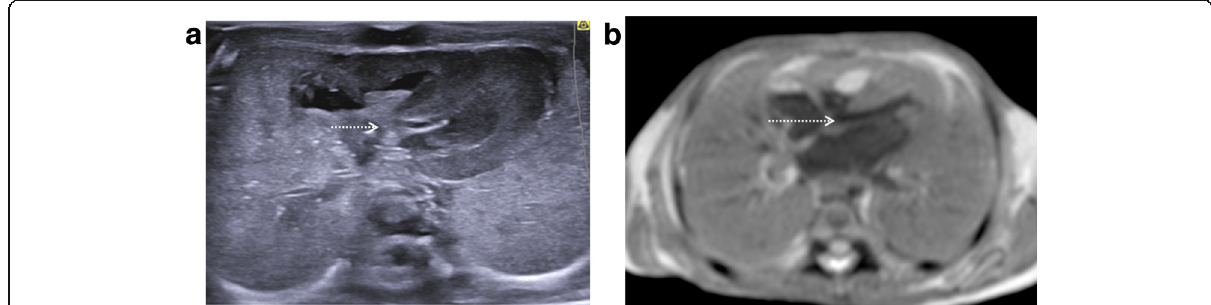
Fig. 11 Paired transverse images of the four cardiac chambers in a foetus at 19 weeks gestation, obtained 6 days after termination of pregnancy. Post-mortem ultrasound image ( a ) and T2-weighted MRI at 1.5T ( b ) both show a small ventricular septal defect (dotted white arrow). It is also interesting to note the normal ‘ expected ’ post-mortem intra-cardiac clot (echogenic material on ultrasound, low signal on MRI) and fluid (hypoechoic on ultrasound, high signal on MRI)